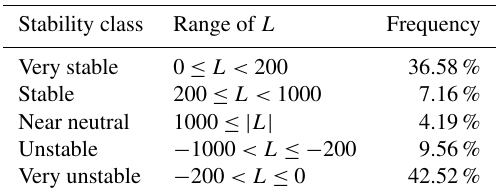
Table 2. Stability classification based on Obukhov length, L , for the combined ASIT and FINO1 data